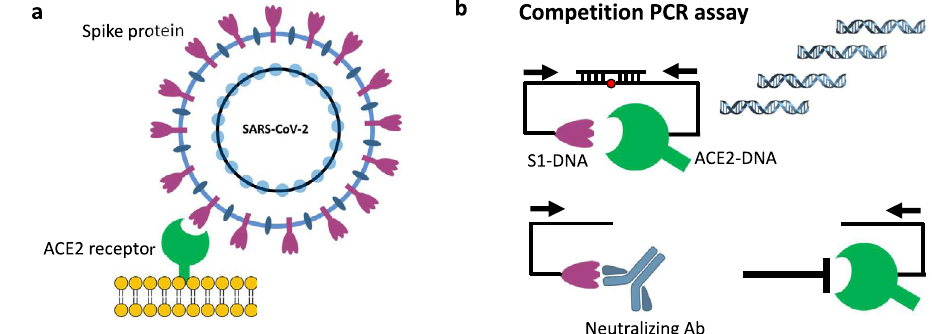
Fig. 1 Principle of SONIA neutralization PCR test. a Viral entry of SARS-CoV-2 is mediated by the binding of the spike protein to the human receptor angiotensin-converting enzyme 2 (ACE2). Disruption of this interaction forms the basis of neutralization by antibodies (NAb). b SONIA Neutralization PCR test reconstructs this interaction using a combination of S1 subunits of the spike protein- and ACE2-DNA conjugates. In the absence of NAb, S1 and ACE2 engage with strong af fi nity, thereby positioning the two DNA barcodes in proximity for subsequent ligation and PCR-ampli fi cation. On the other hand, binding of NAb blocks S1 subunit from binding ACE2, leaving the two DNA barcodes separated. Since each barcode has only one PCR primer binding site, they cannot be separately ampli fi ed. Therefore, the quantities of NAb are correlated with the decrease of PCR amplicon